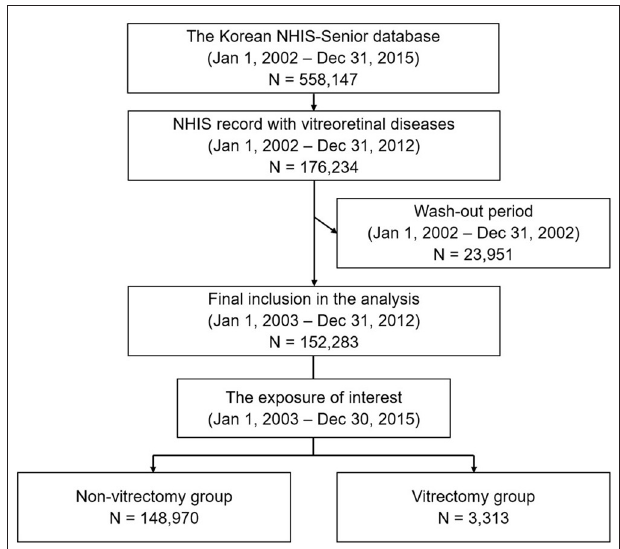
FIGURE 1 | Flow-chart illustrating the study